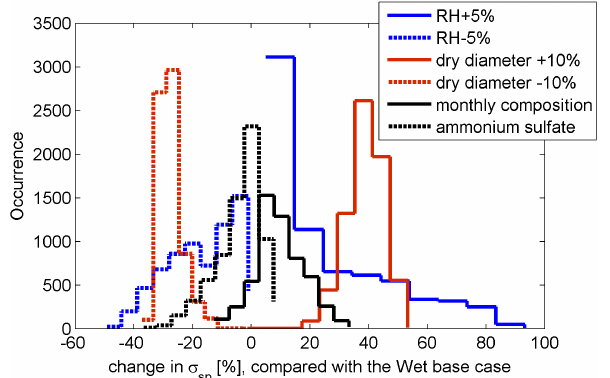
Figure 10. Sensitivity of the hourly calculated σ sp to RH, aerosol dry size and chemical composition as compared with the Wet base case (see Table